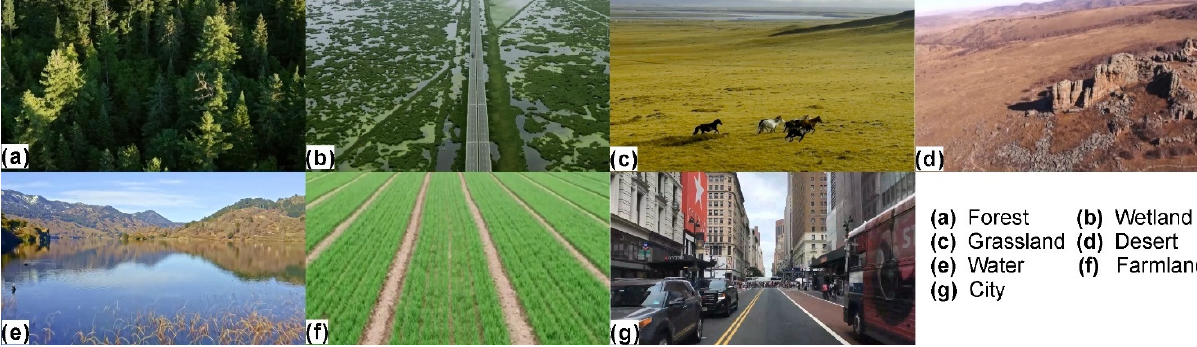
Figure 1. Experimental video materials.